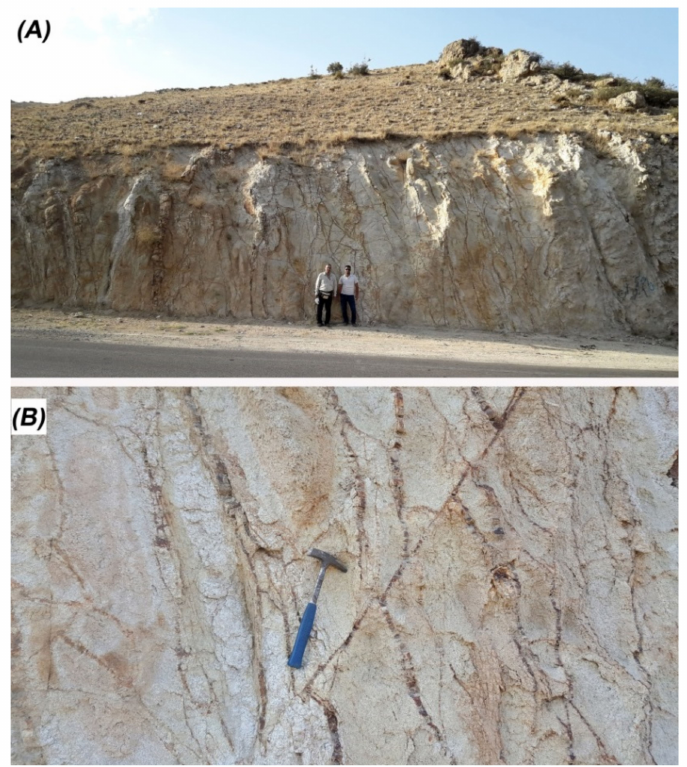
Figure 18. Breccia zone (quartz veins) in the granitic host rocks in the Noghdouz gold mineralization area. ( A ) View of breccia zone (quartz veins) in the granitic host rocks (Ahar-Meshkinshahr road); ( B ) Close view of quartz veins in the breccia zone and advanced argillic